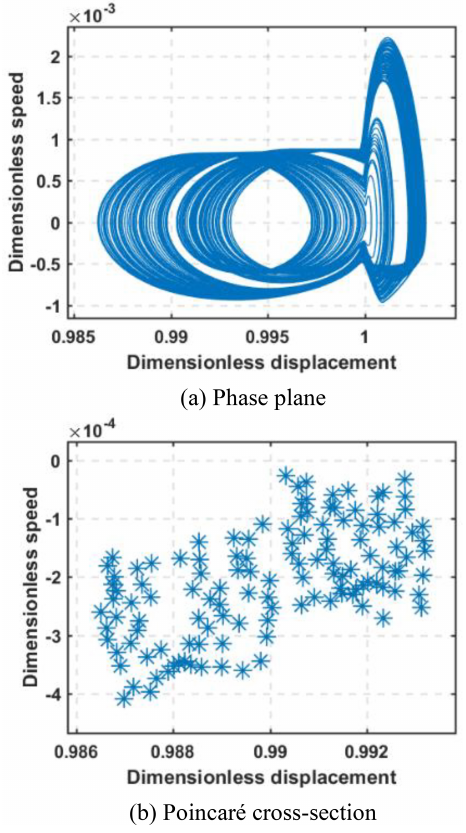
Figure 8. System response of w k = 75